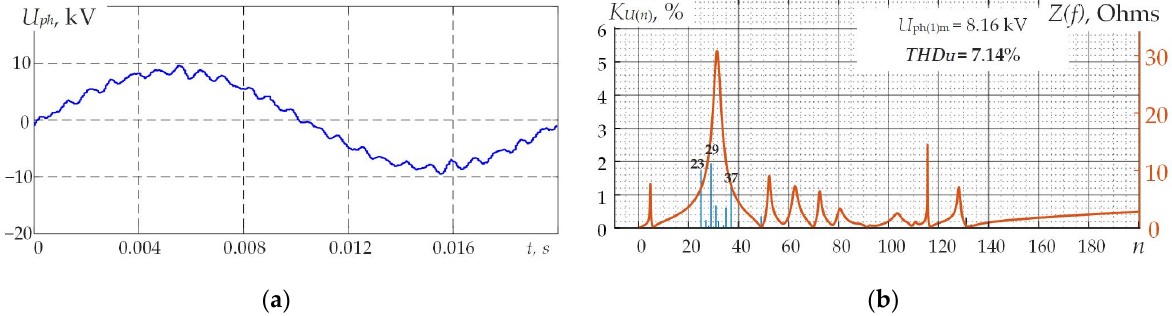
Figure 14. The grid diagram for the key electric drives of the cold-rolling mill.